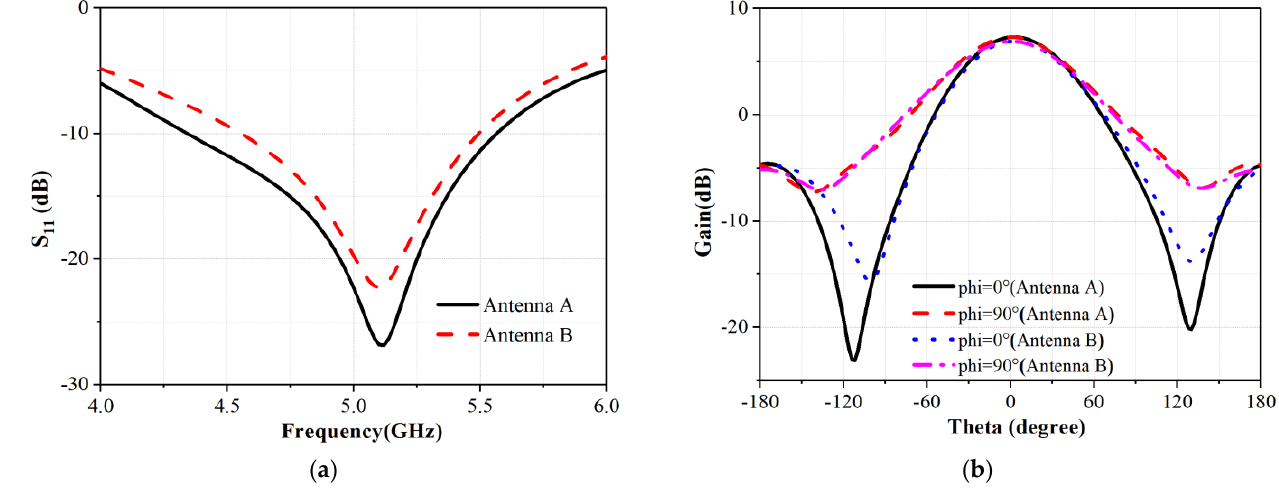
Figure 12. Radiation performances of antenna A and antenna B. ( a ) S 11 ; ( b ) far−field patterns.